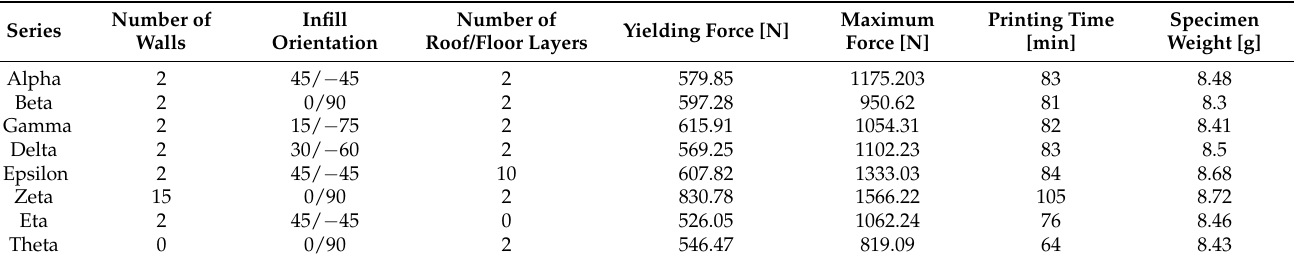
Table 3. Results and specification of specimen Table 3 . Results and specification of specimen series.